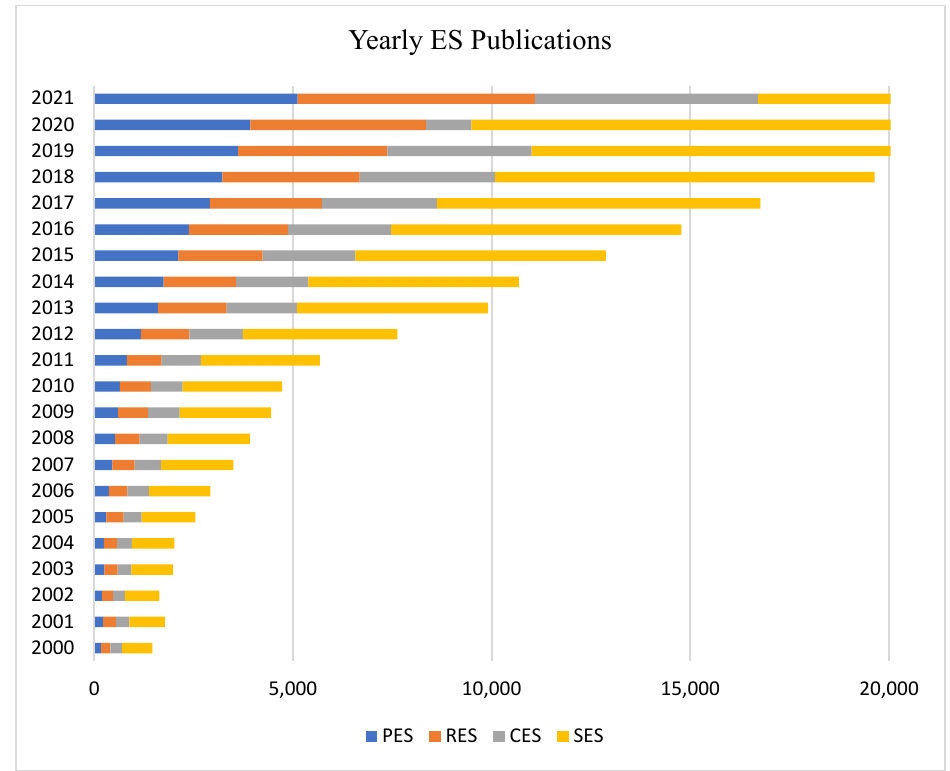
Figure 3. Number of publications on ecosystem services classification—chronology. Where PES indicates provisioning ecosystem services, RES is regulating ecosystem services, CES is cultural ecosystem services and SES is supporting ecosystem services.